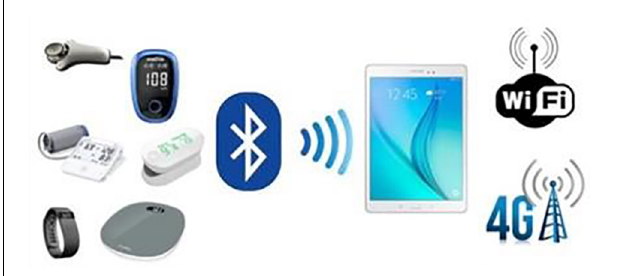
FIGURE 1 | Ger-e-Tec’s connected non-intrusive medical sensors. Copyright: Predimed Technology, Schiltigheim, France.